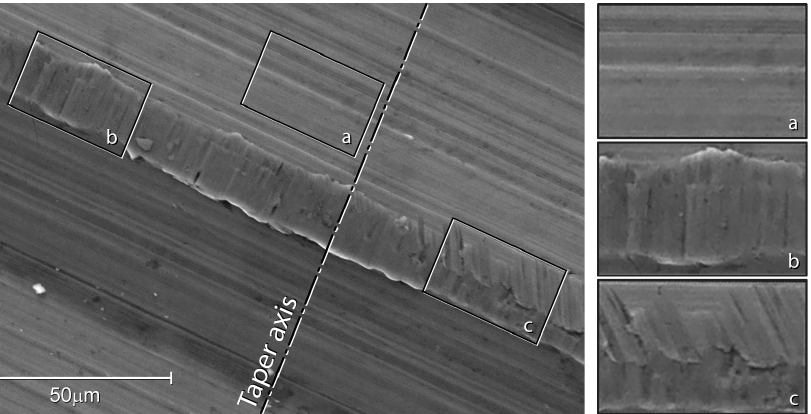
Figure 4. SEM image of taper surface (magnification: 1600x, working distance: 10.7 mm; accelerating voltage: 20.00 kV). Detail ( a ): original surface left from the cutting tool. Detail ( b ): parallel scars aligned with the taper axis, likely caused by fretting. Detail ( c ): parallel scar sloped towards the taper axis, which was likely generated during head disassembly.